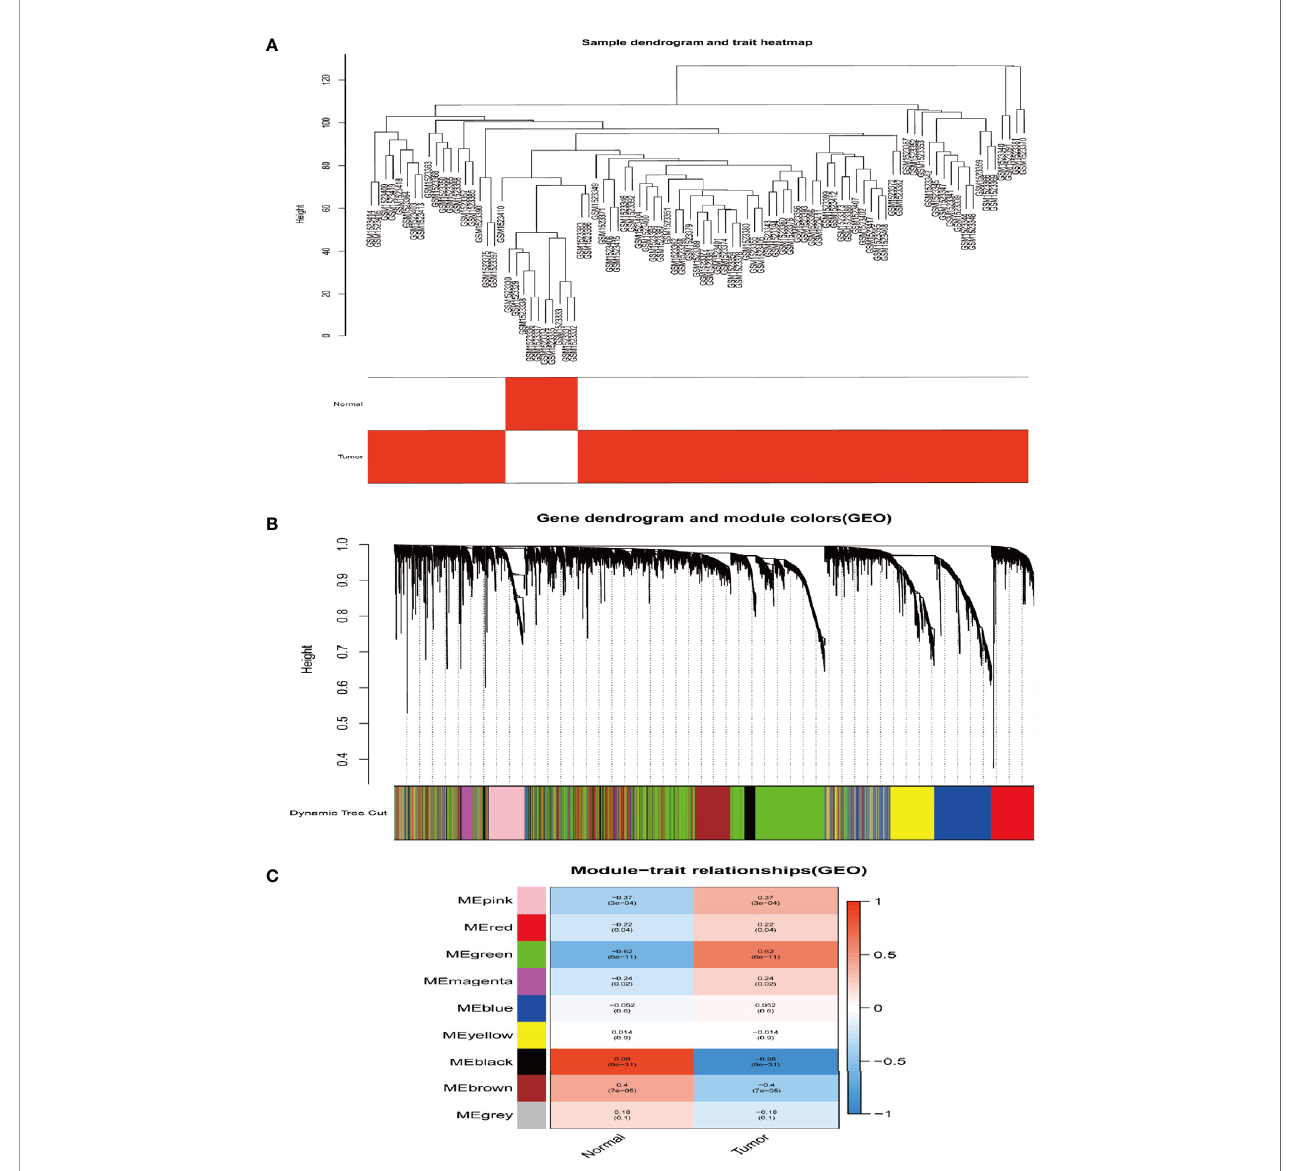
FIGURE 4 | Co-expression modules construction and selection in the GSE62232 dataset. (A) Samples clustering and trait heatmap. (B) Dendrogram of co- expression network modules were clustered with dissimilarity according to topological overlap (1-TOM). (C) Heatmap of the correlation between the module eigengenes (ME) and